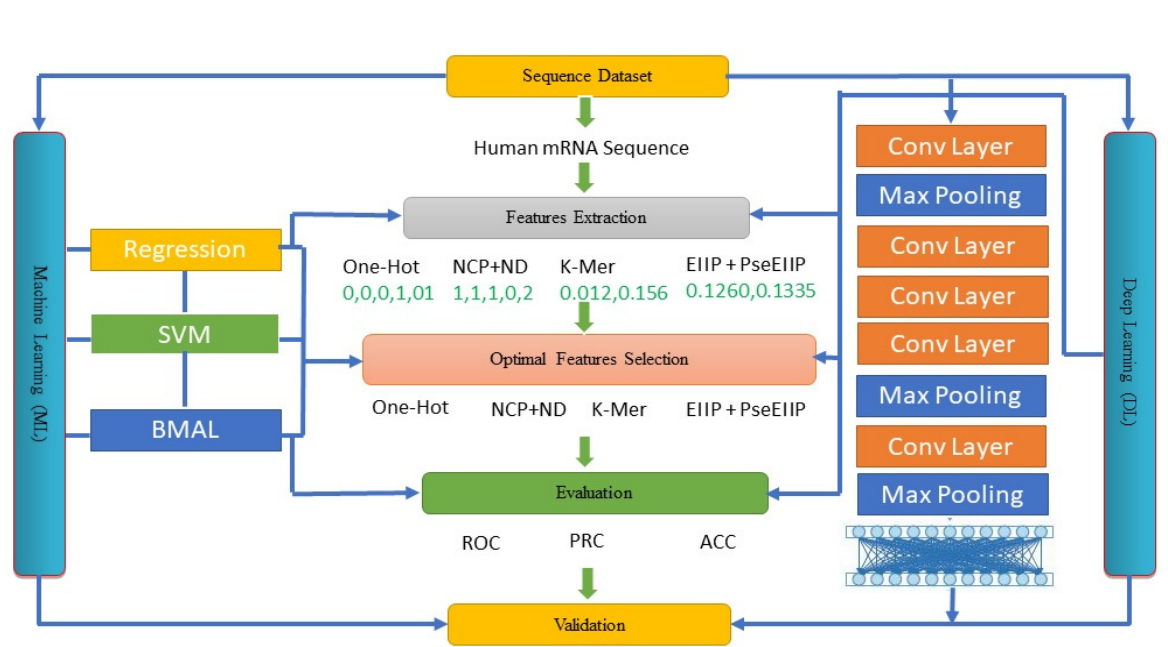
Figure 1. The chosen deep learning model (DL-ac4C) with the best performance on the validation set, mRNA.